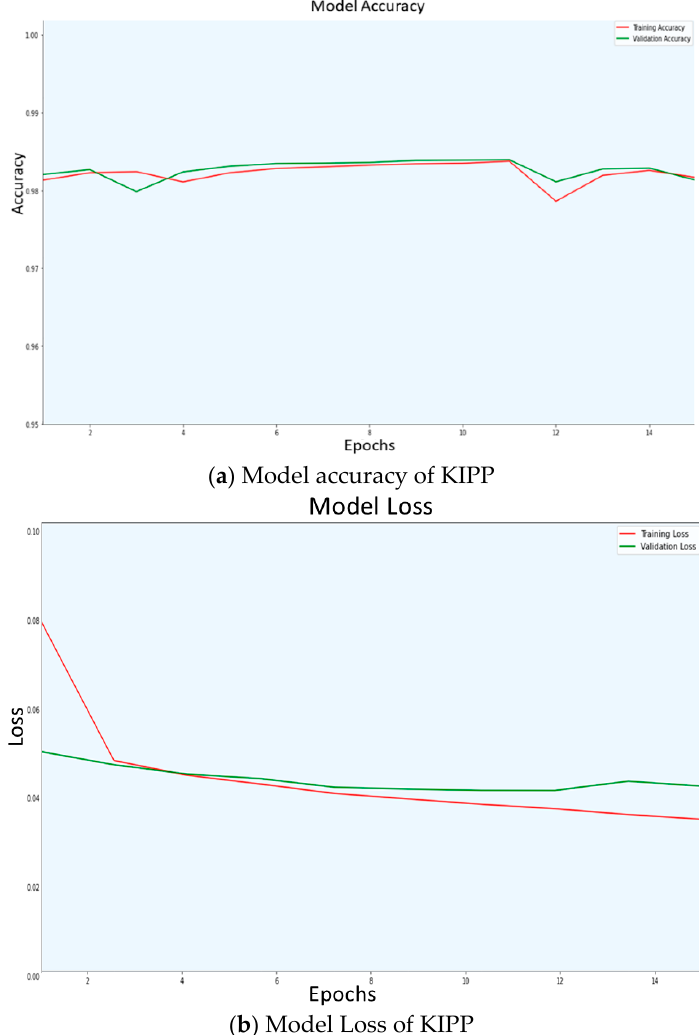
Figure 12. Performance analysis of the deep learning model KIPP.